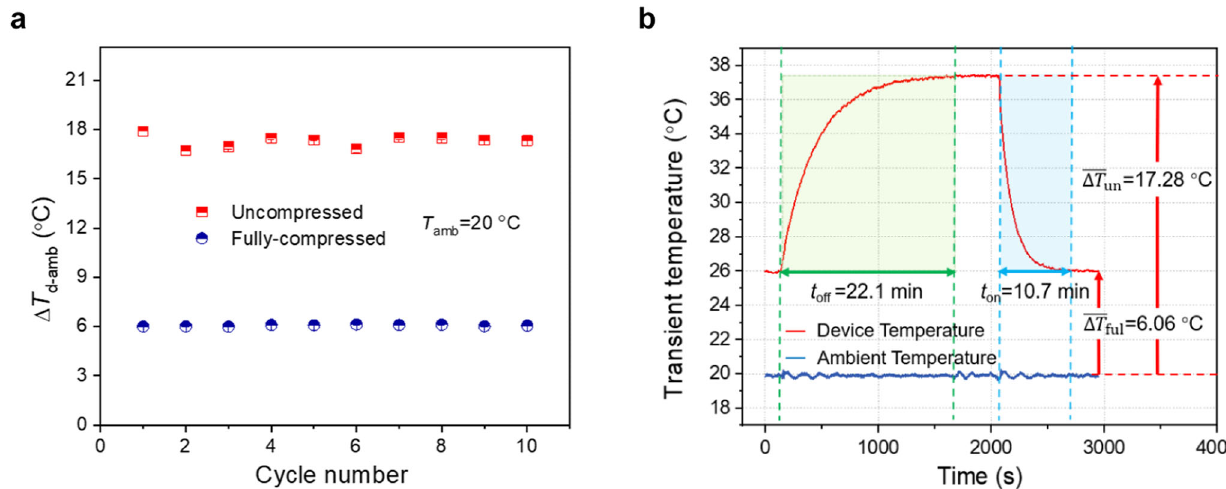
Fig. 6 Performance on reliability and response time. a Device-ambient temperature difference ( Δ T d-amb ) at the uncompressed and fully compressed states during cycling. The graphene foam is stable with very small temperature deviation of each test point. b Example transient temperature response for the system during 1 cycle of compression. The time to steady state when transitioning from the “ on ” (compressed) to “ off ” (uncompressed) state is ~22 min, while transitioning from “ off ” to “ on ” is ~11 min.